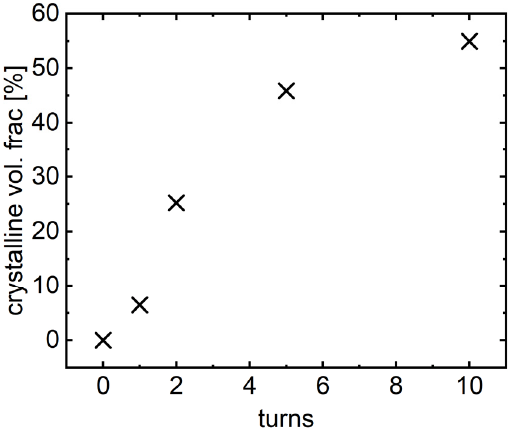
Figure 12. Evolution of the crystalline volume fraction in alloy B (Fe 81.2 Co 4 Si 0.5 B 9.5 P 4 Cu 0.8 ) vs. the number of HPT turns calculated from the DSC data (for details, see text).